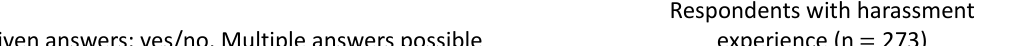
Respondents with